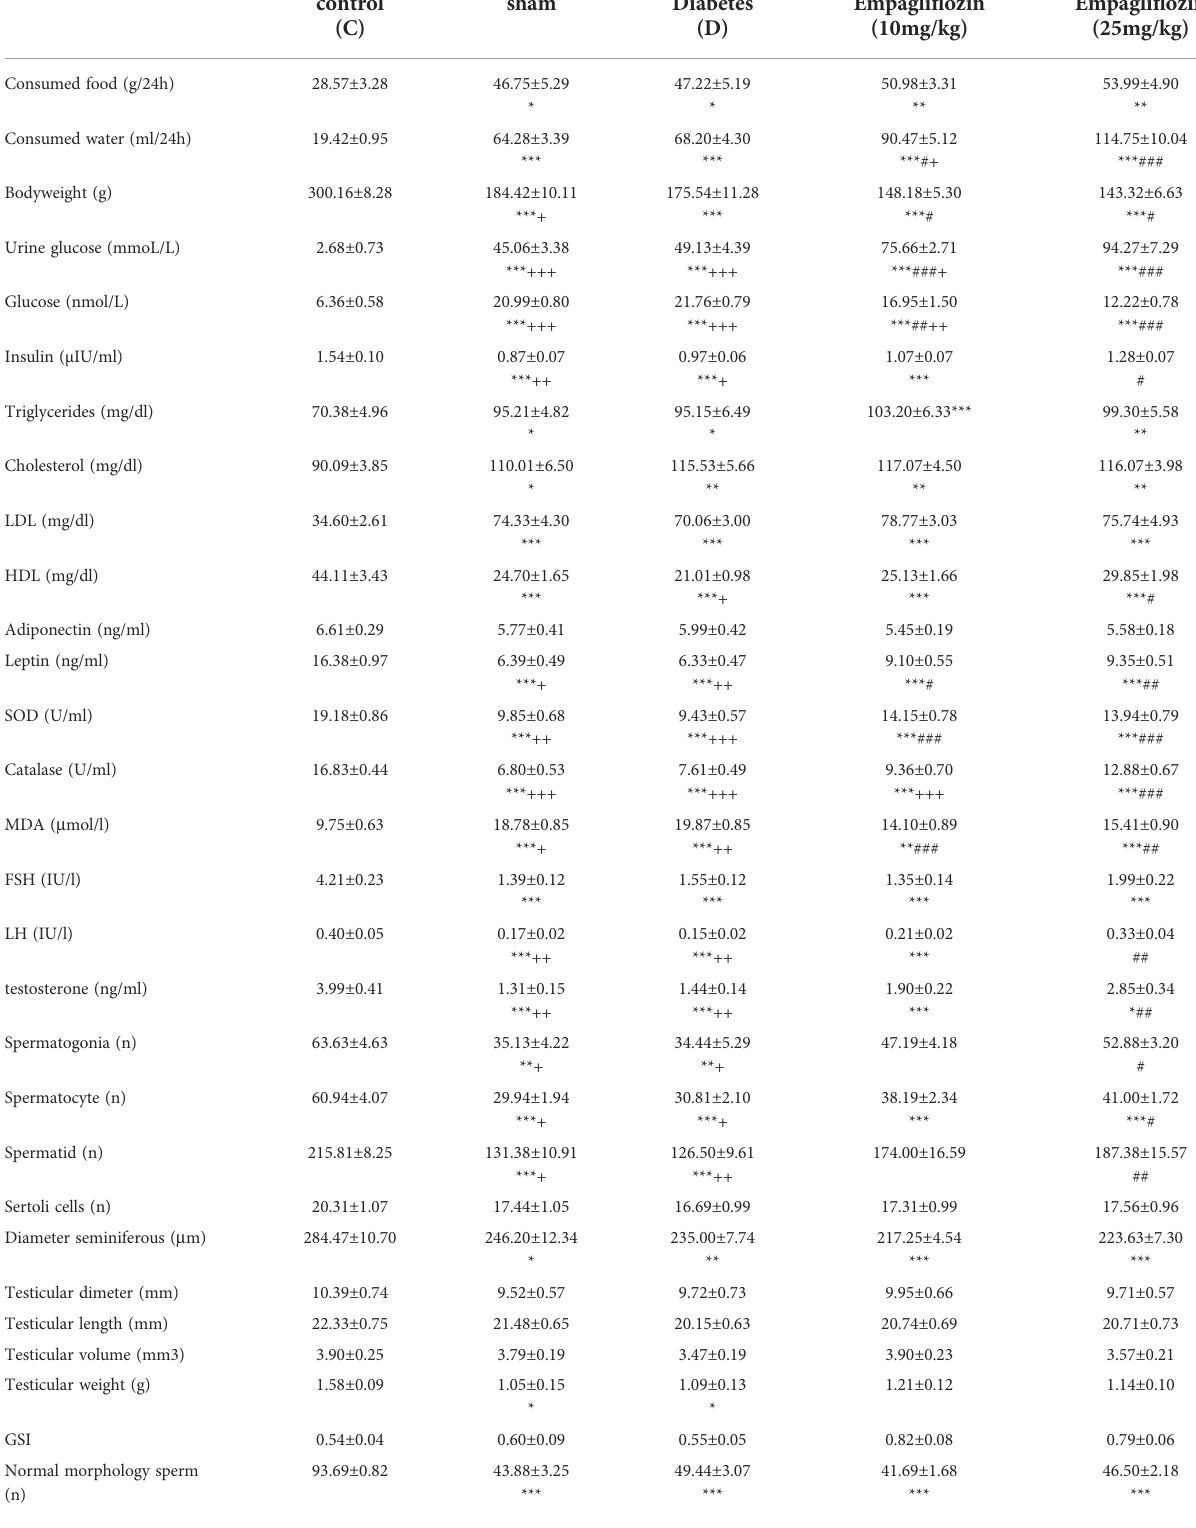
TABLE 1 Physiological, biochemical, and histological fi ndings of the diabetic rats and